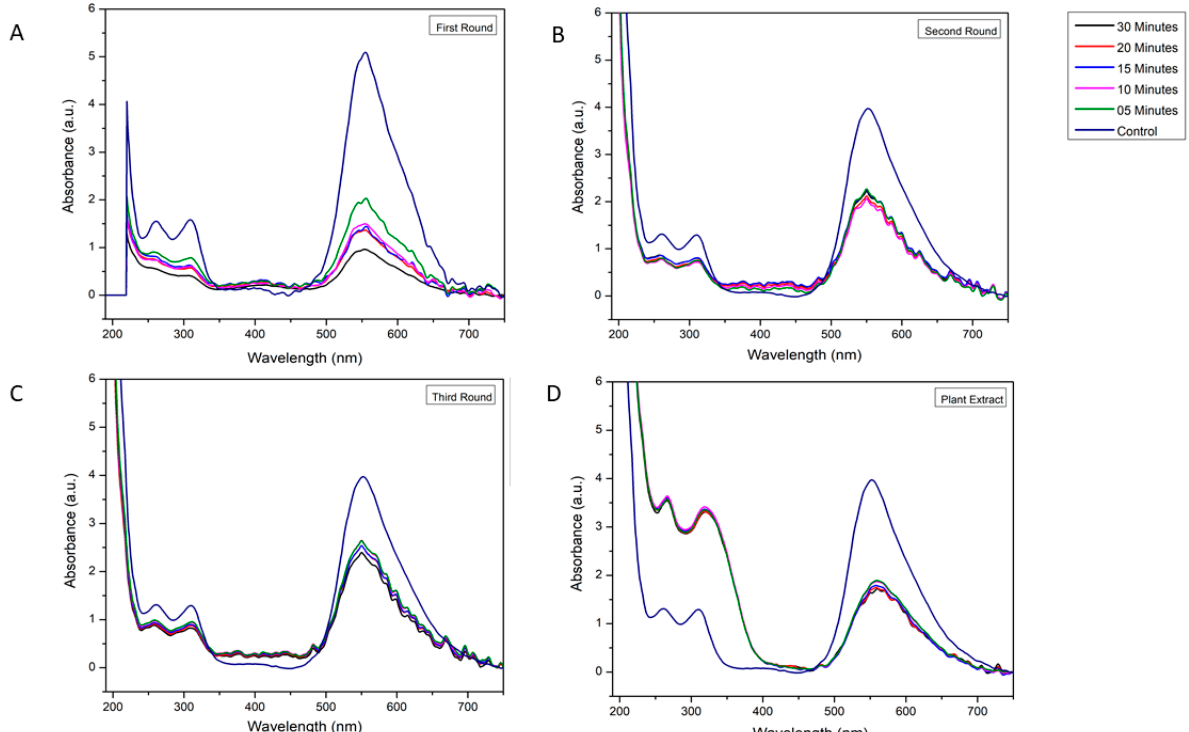
Figure 5. UV spectra of oven dried M-OMAgNs dye degradation in the first round ( A ), oven dried M-OMAgNs dye degradation in the second round ( B ), oven dried M-OMAgNs dye degradation in the third round ( C ), and methanol plant extract dye degradation ( D ).